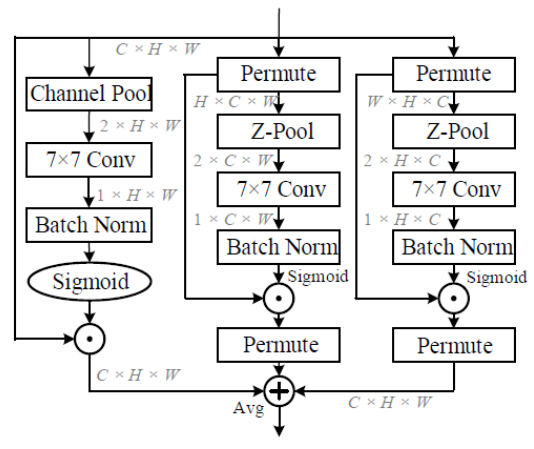
Figure 2. Triple attention architecture